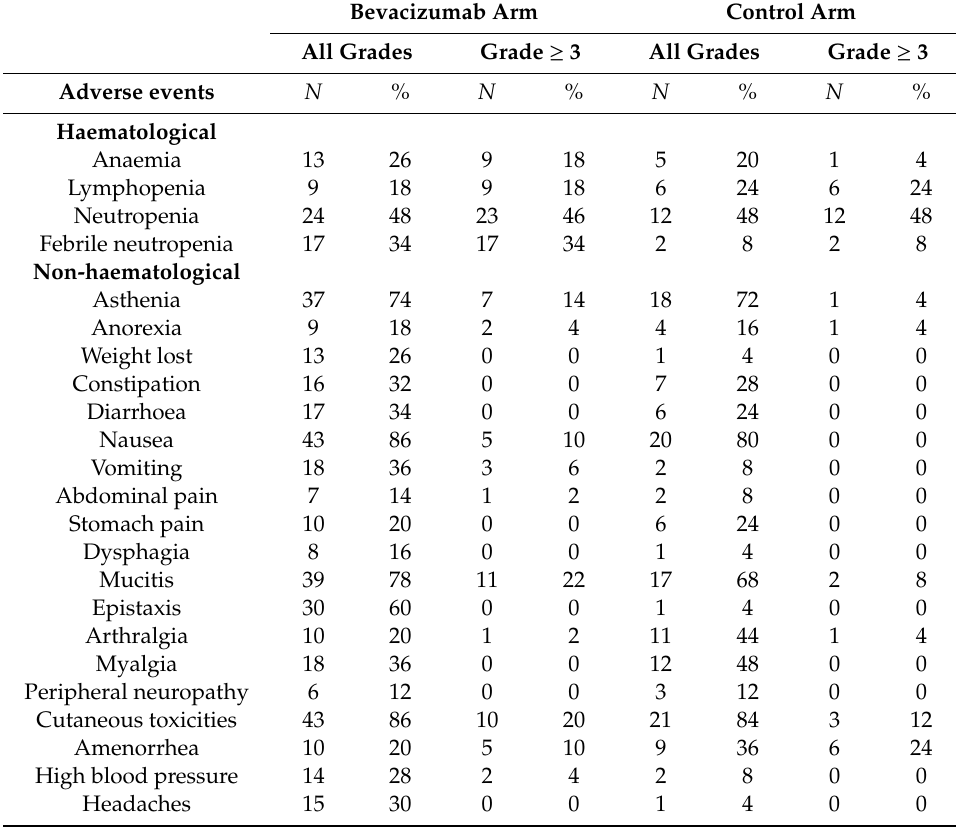
Table 2. Most common adverse events (Common Terminology Criteria for Adverse Events version 3.0). Only adverse events (AEs) related to treatment and with an incidence ≥ 10% for all grades or ≥ 5% for grade ≥ 3 are